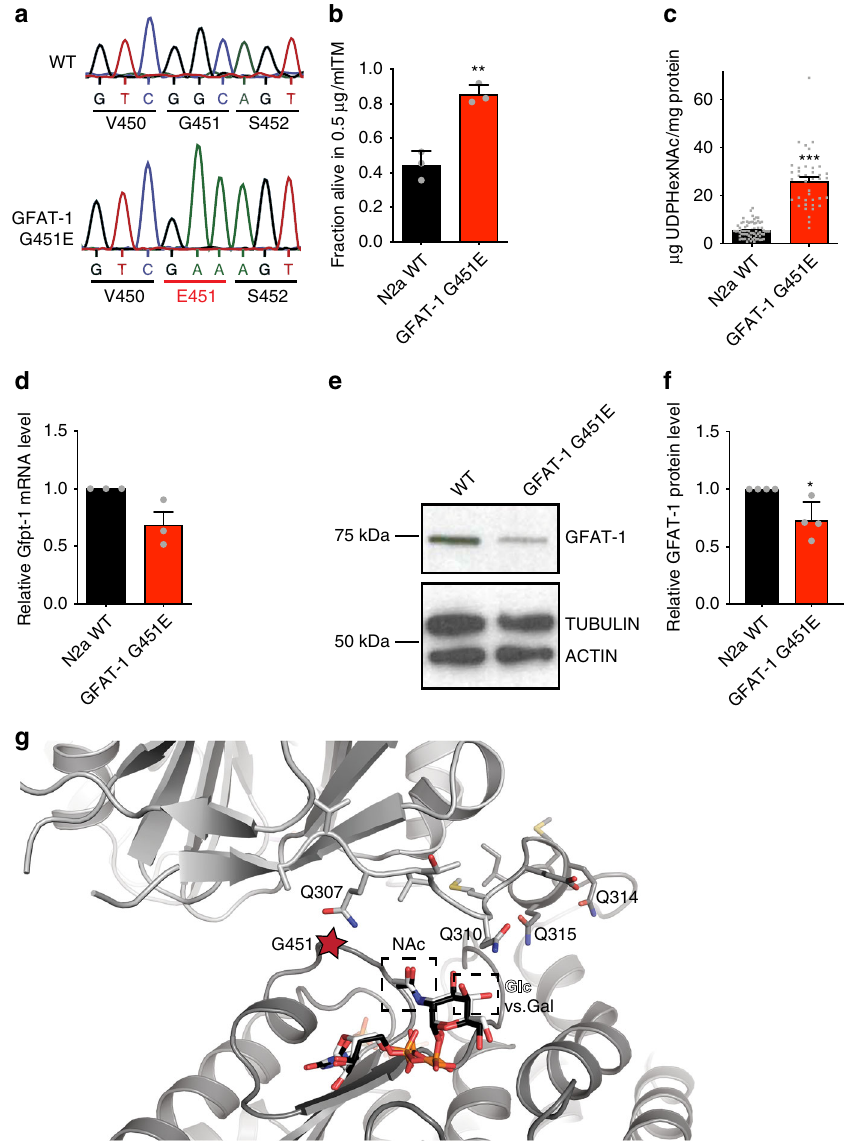
Fig. 7 The G451E substitution activates GFAT-1 in mammalian cells. a Sanger sequencing results of wild type (WT) and G451E genomic Gfpt1 engineered in mouse neuroblastoma cells (N2a). b Cell viability (XTT assay) of WT and GFAT-1 G451E-engineered N2a cells after a 48 h treatment with 0.5 µ g/ml tunicamycin (TM) (mean + SEM, n = 3, ** p < 0.01, unpaired t -test). c UDP-HexNAc level in WT and GFAT-1 G451E N2a cells (mean + SEM, n ≥ 25, *** p < 0.001, unpaired t -test). d Relative Gfpt1 mRNA-level (qPCR) of GFAT-1 G451E N2a cells normalized to WT controls (mean + SEM, n = 3). e , f Western blot analysis of endogenous GFAT-1 protein levels from WT and GFAT-1 G451E N2a cells ( e ), including quanti fi cation relative to tubulin and the WT control cells ( f , mean + SD, n = 4, * p < 0.05, unpaired t -test). g Close-up of the interdomain linker and UDP-GlcNAc-binding site in GFAT-1 monomer A. The protein is presented as a cartoon. The isomerase domain is colored in dark gray and the glutaminase domain is colored in light gray. UDP-GlcNAc (white sticks) and UDP-GalNAc (black sticks) are superimposed. Residues of the interdomain linker (sticks) and the position of G451 (red star) are highlighted. The NAc and C4 hydroxyl groups of UDP-GlcNAc/UDP-GalNAc are pointing towards the interdomain linker (black boxes). Source data are provided as a Source Data fi